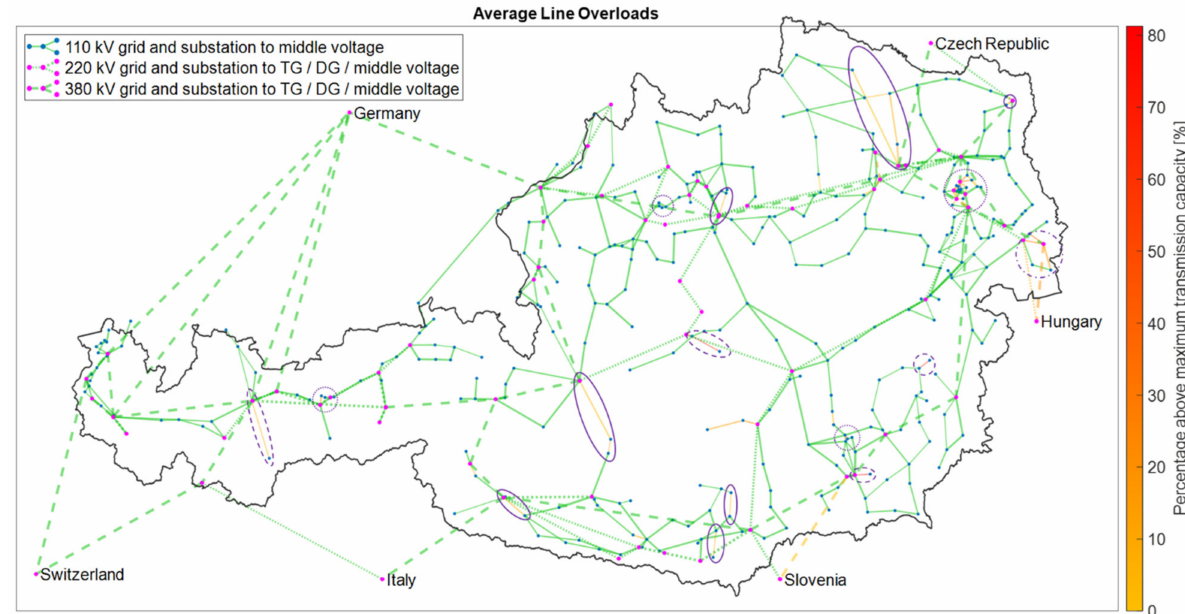
Figure 15. Average line overloads of Austria’s power grid—Scenario